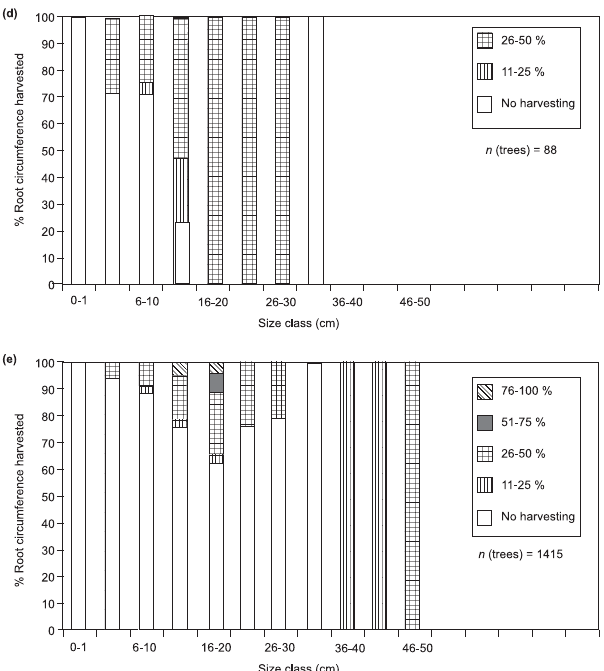
Fig. 5(d-e). The degree of root disturbance through harvesting of Catha edulis at sites (d) a roadside site near Hazyview, and (e) pooled